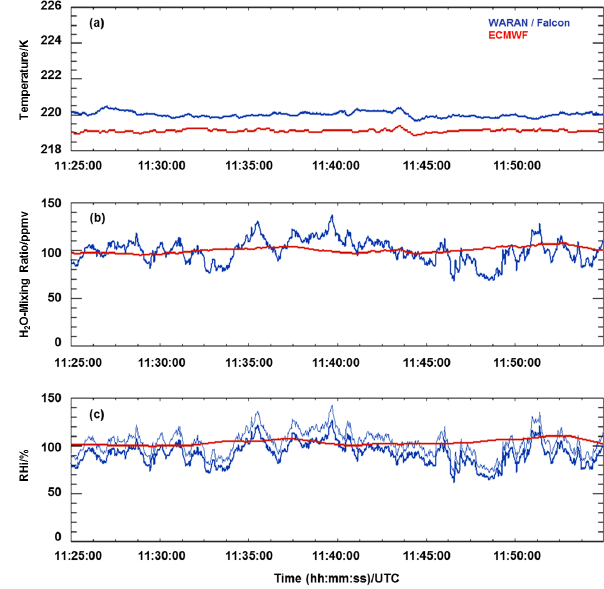
Figure 5. Comparison of in situ temperature, water vapour and RHi measurements on 4 November 2010 from WARAN onboard the Fal- con (blue lines) with data from ECMWF model analysis (red lines). (a) Static air temperature, (b) water vapour mixing ratio and (c) rela- tive humidity over ice along the flight track. The red line shows RHi calculated from ECMWF temperature and water vapour data, the thick blue line shows RHi calculated from WARAN water vapour mixing ratio and Falcon in situ temperature measurements, and the thin blue line shows RHi calculated from WARAN water vapour mixing ratio measurements and ECMWF model